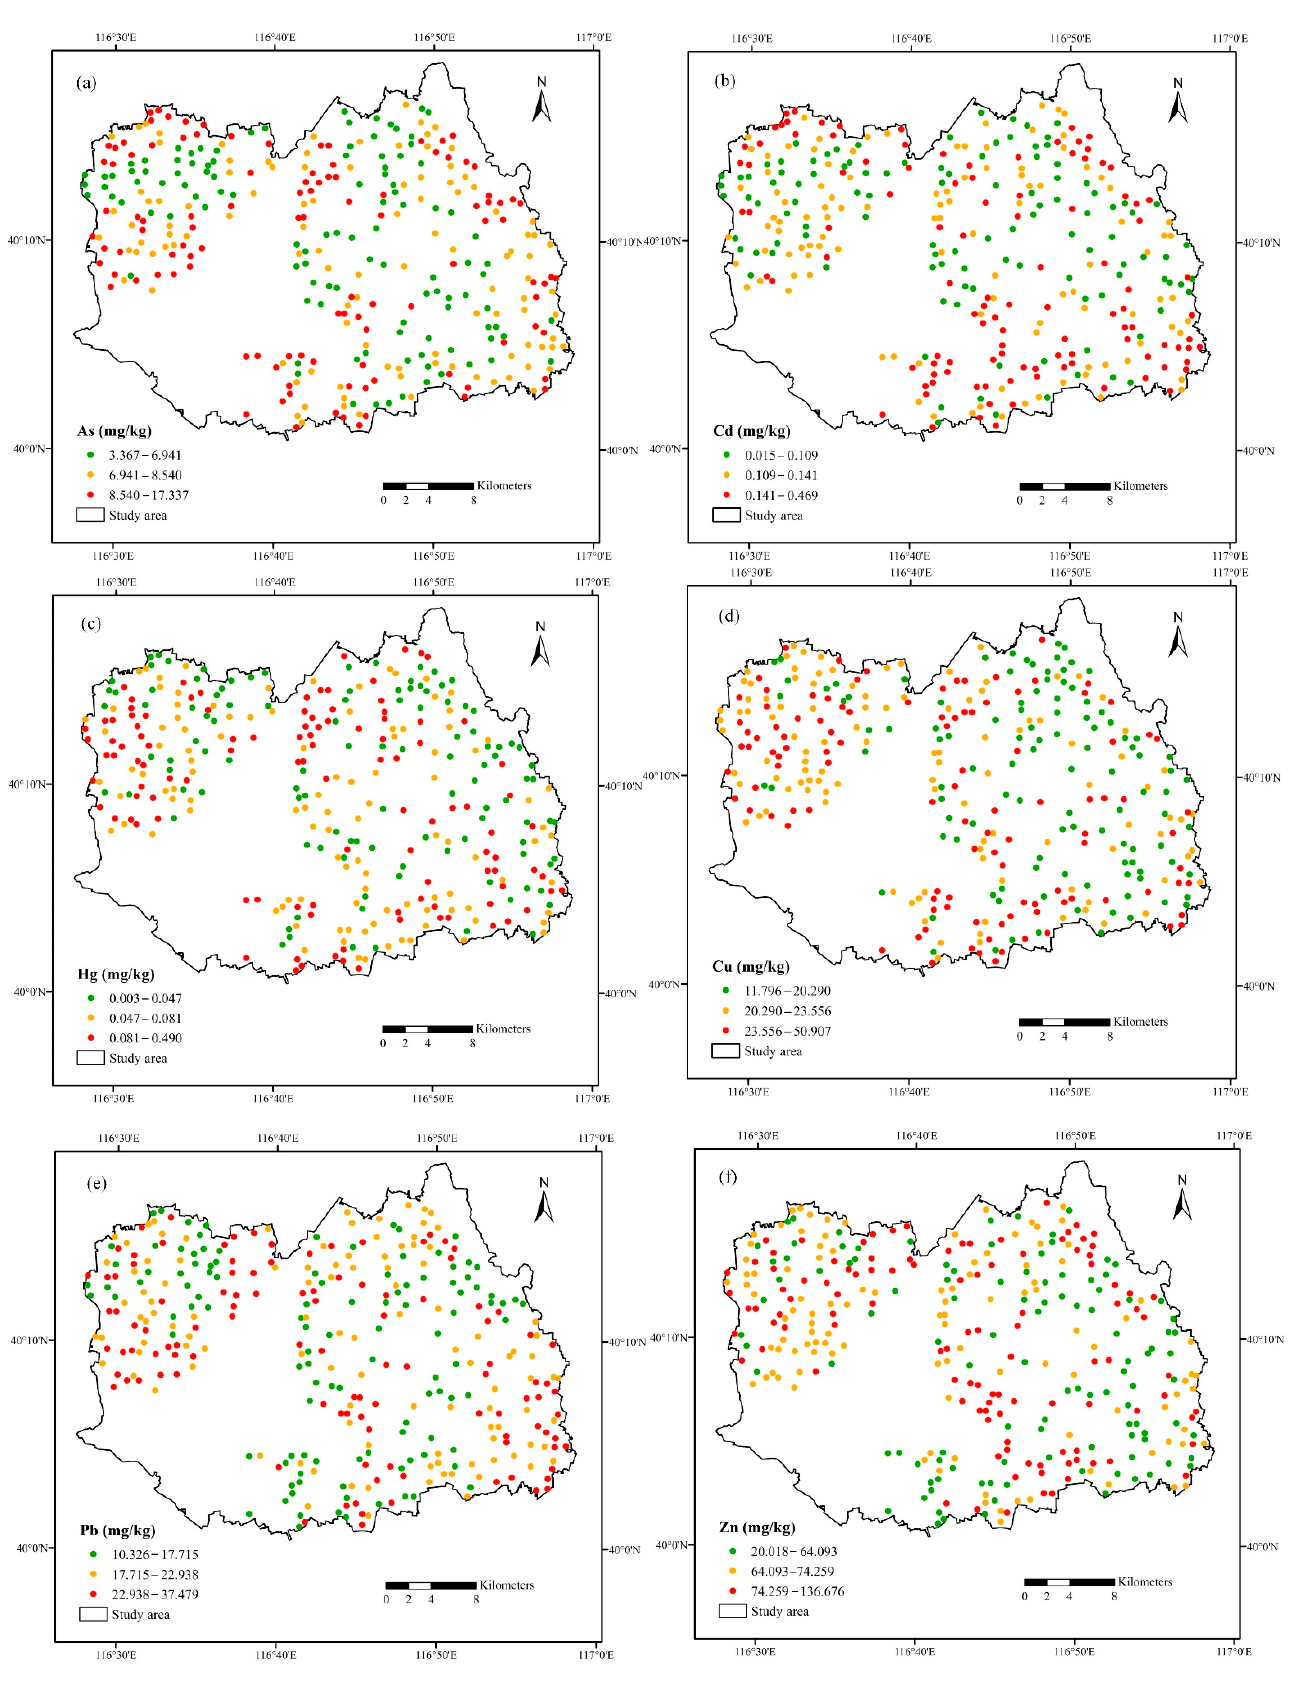
Figure 2. Spatial distribution of As ( a ), Cd ( b ), Hg ( c ), Cu ( d ), Pb ( e ), and Zn ( f ) of Shunyi District, China.